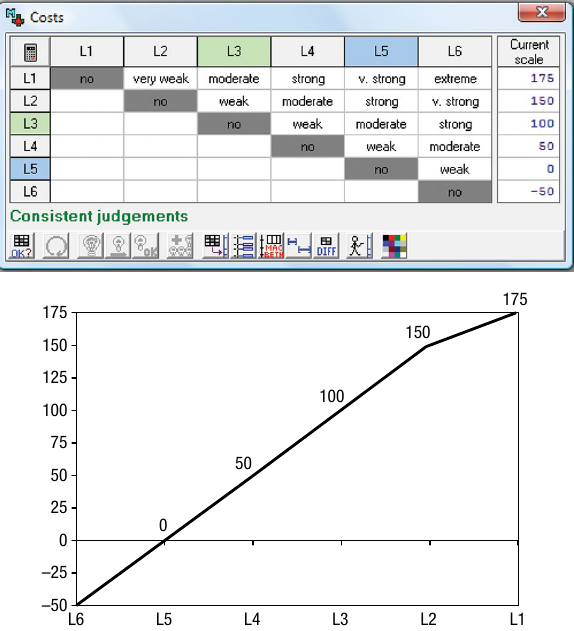
( Cost to Income 2